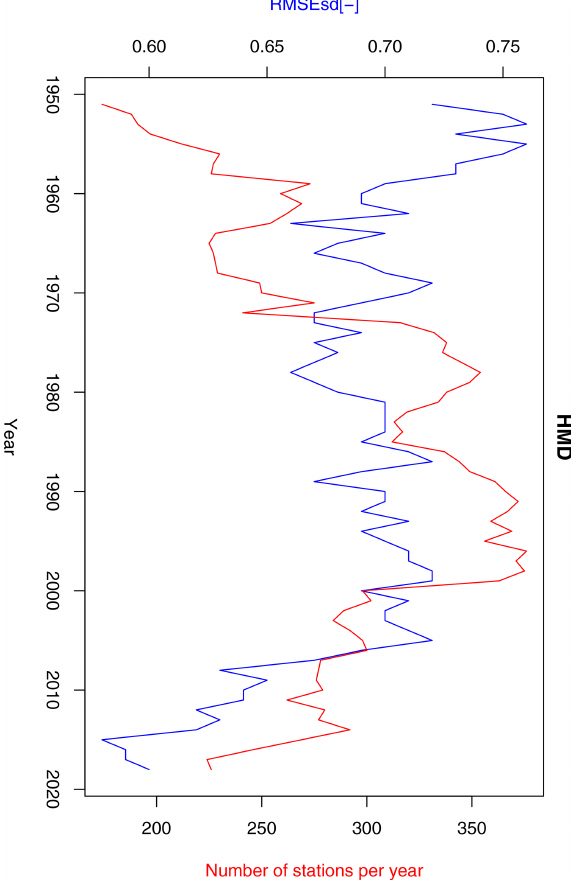
Figure 17. Annual RMSEsd median (blue) and number of avail- able stations per year (red) for relative humidity in the period 1951– 2019. The daily results, also summarized in Table 1, were used for calculating the annual